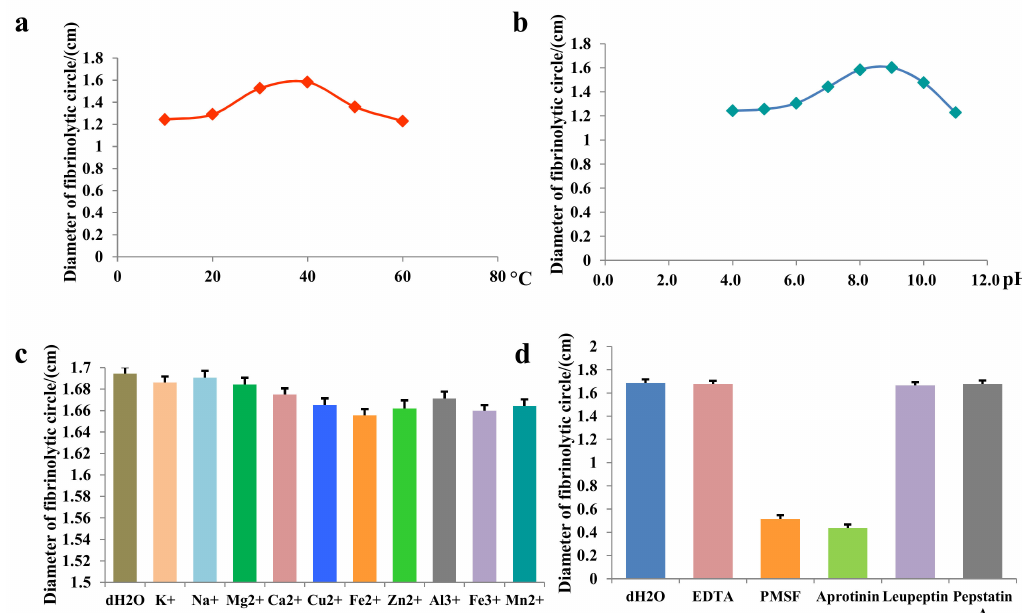
Figure 3. The enzymatic properties of SK. Effects of ( a ) temperature: 10, 20, 30, 40, 50, 60 ◦ C, ( b ) pH: 4, 5, 6, 7, 8, 9, 10, 11, ( c ) metal ions: K + , Na + , Mg 2+ , Ca 2+ , Cu 2+ , Fe 2+ , Zn 2+ , Al 3+ , Fe 3+ , Mn 2+ ( d ) inhibitors: EDTA, PMSF, Aprotinin, leupeptin, pepstatin A on fibrinolytic activities of